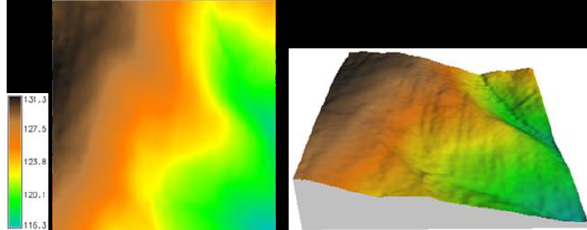
Figure 2. Bare earth elevation model under normal tension without smoothing parameter Lidar data used to create DEM map of study site using spline method under normal tension and without smoothing parameter (Figure 2) in 1x1 meter resolution. We assume this elevation model is our site’s certain elevation model so we convert GPS data’s horizontal coordinate to bare earth lidar data’s coordinate system and unit to compare our elevation model with bare earth lidar data elevation